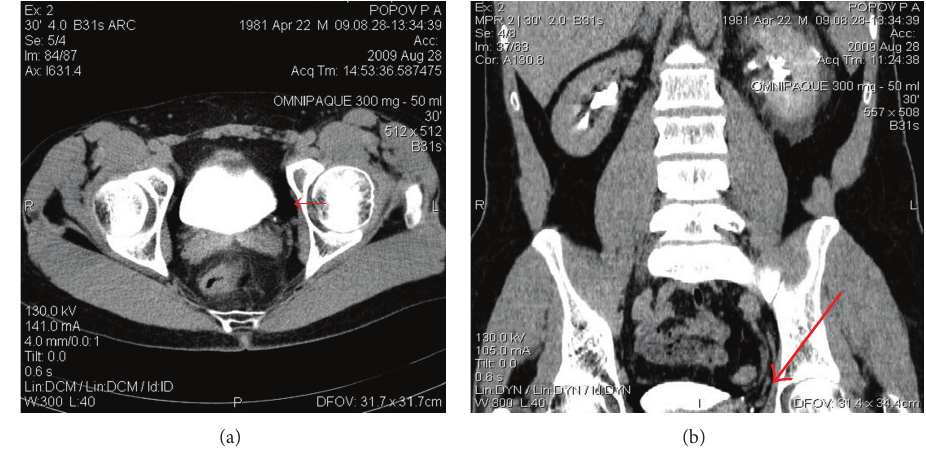
Figure 2: 4mm stone in the lower third of the left ureter (red arrow). Axial (a) and sagittal (b) images.